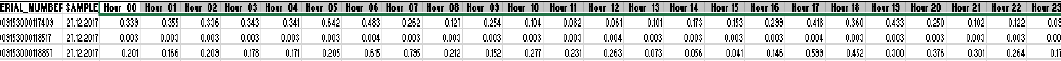
Figure 5. The sequence of the power actives recorded in the database.